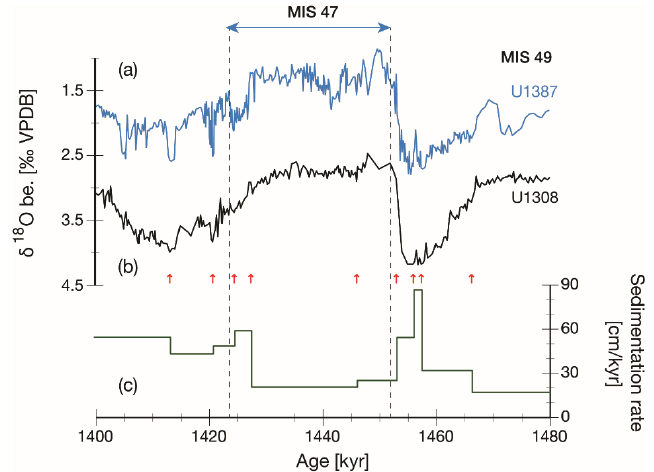
Figure 2. The age model for IODP Site U1387 was established by tuning its benthic δ 18 O record ( a ) to the one of IODP Site U1308 ( b ) [10]. Tuning points are indicated by red arrows and listed in Table 1. ( c ) Sedimentation rates for IODP Site